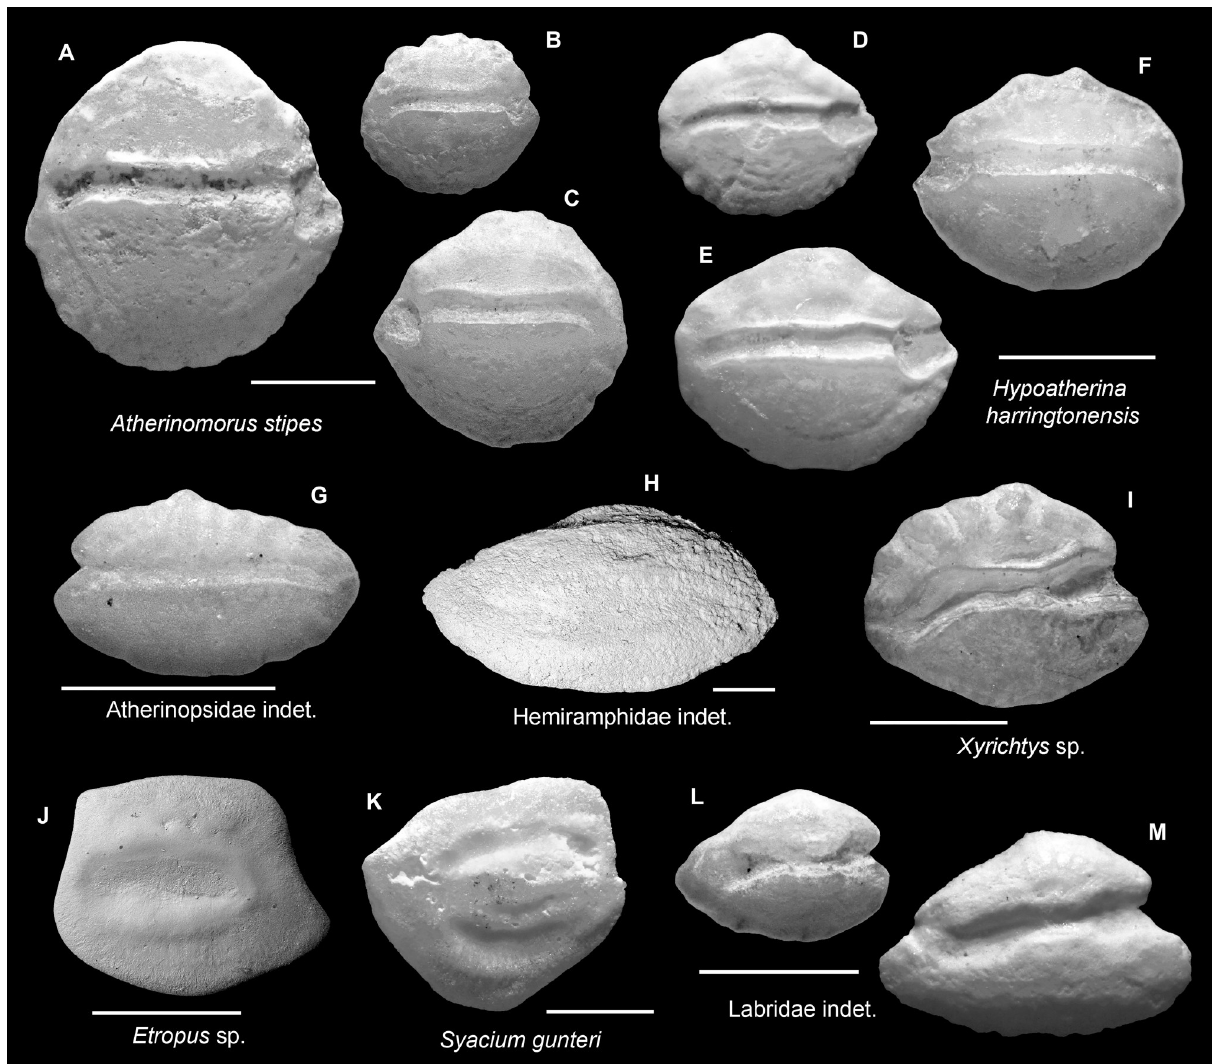
D, E, left otoliths, Airport Point; F, right otolith, Cayo Adriana. G. Atherinopsidae indet., right otolith, sub-Recent, Playa Estrella. H. Hemiramphidae indet., right otolith, sub-Recent, SW Bocas Island. I. Xyrichtys sp., left otolith, mid-Holocene, Duverge Road Section. J. Etropus sp., right otolith, sub- Recent, STRI Point. K. Syacium gunteri , left otolith, mid-Holocene, Las Clavellinas. L, M. Labridae indet., left otoliths, sub-Recent, L, Airport Point; M, Hickory Ship, La